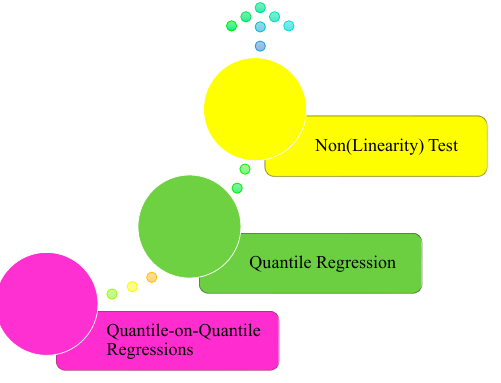
Figure 2. Flow of analysis.